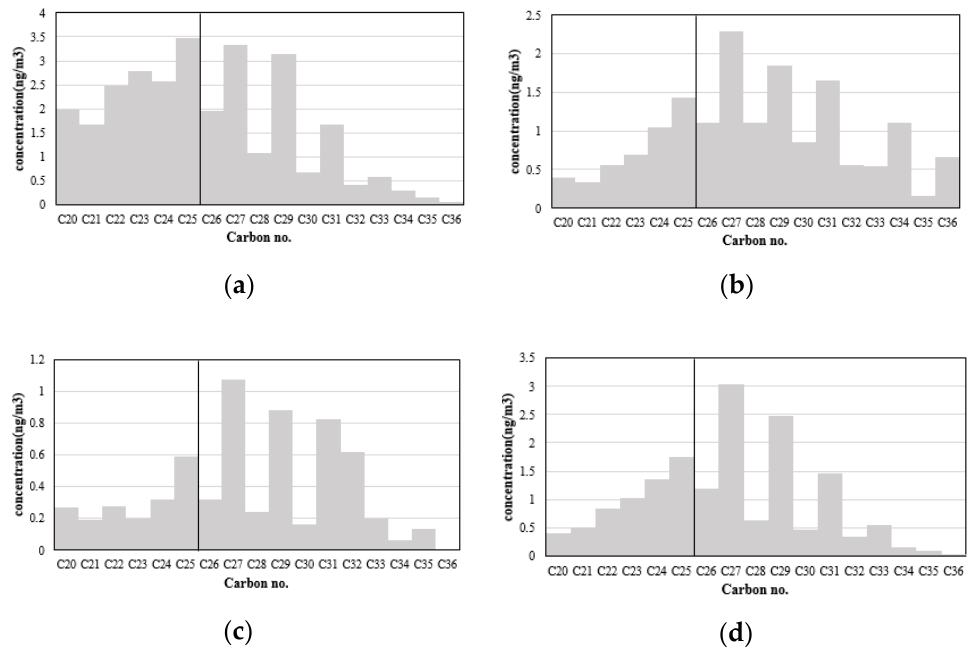
Figure 4. Seasonal averaged n-alkane concentrations. ( a ) Winter; ( b ) Spring; ( c ) Summer; ( d ) Fall. The scale of the y axis for each figure is different.